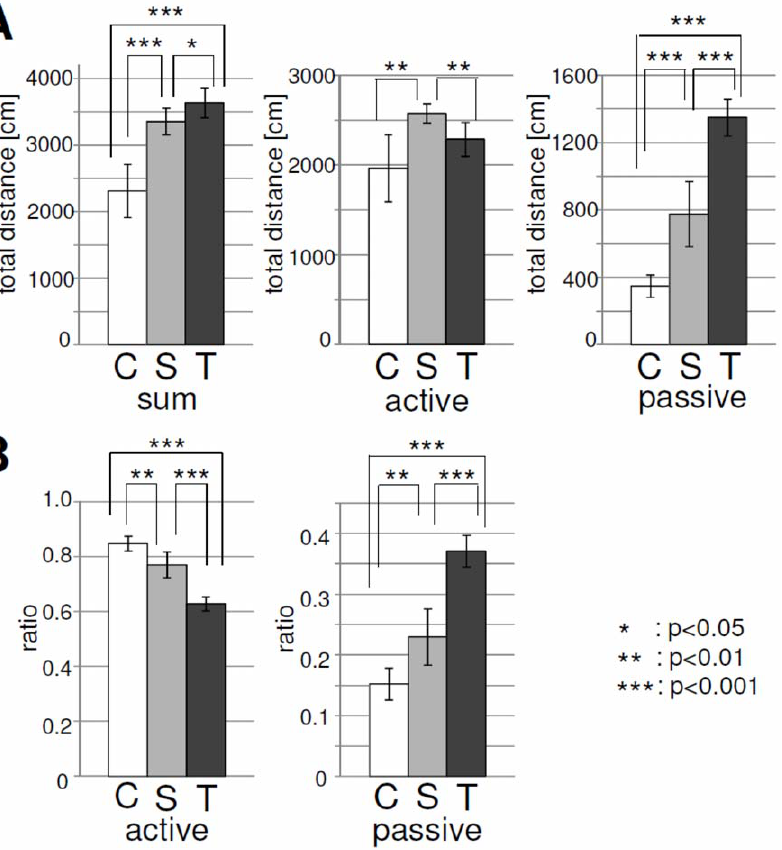
Figure 5. Comparisons of the averaged total traveling distances and the ratio of the traveling distances of the active and passive elements. A. Comparisons of the averaged total traveling distances between the circular, square, and triangular elements. Left, middle, and right figures show the case of the sum of the active and passive elements, the active elements, and the passive elements, respectively. A total of 2000 timesteps are used to calculate the total traveling distance. The plots show the averaged value over all the trials. In the left figure, the averaged total traveling distances for the circular, square, and triangular elements are 0.231 + 0.040 ( | 10 4 ), 0.335 + 0.020 ( | 10 4 ), and 0.363 + 0.022 ( | 10 4 ), respectively. In the middle figure, they are 0.196 + 0.037 ( | 10 4 ), 0.258 + 0.011 ( | 10 4 ), and 0.229 + 0.019 ( | 10 4 ), respectively. In the right figure, they are 0.0348 + 0.0066 ( | 10 4 ), 0.0776 + 0.0193 ( | 10 4 ), and 0.135 + 0.011 ( | 10 4 ), respectively. B. Comparisons of the averaged ratio of the traveling distances of the active elements (left) and the passive elements (right) in the total traveling distances of the circular, square, and triangular elements. The ratio is calculated for each trial and averaged over all the trials. In the active elements case, the averaged ratios for the circular, square, and triangular elements are 0.848 + 0.026, 0.770 + 0.046, and 0.629 + 0.026, respectively. In the passive elements case, they are 0.152 + 0.026, 0.230 + 0.046, and 0.371 + 0.026, respectively. For both A. and B. , the error bars show the standard deviation. For each plot, asterisks indicate significant differences, (cid:2) : p v 0 : 05 , (cid:2)(cid:2) : p v 0 : 01 , and (cid:2) (cid:2) (cid:2) : p v 0 : 001